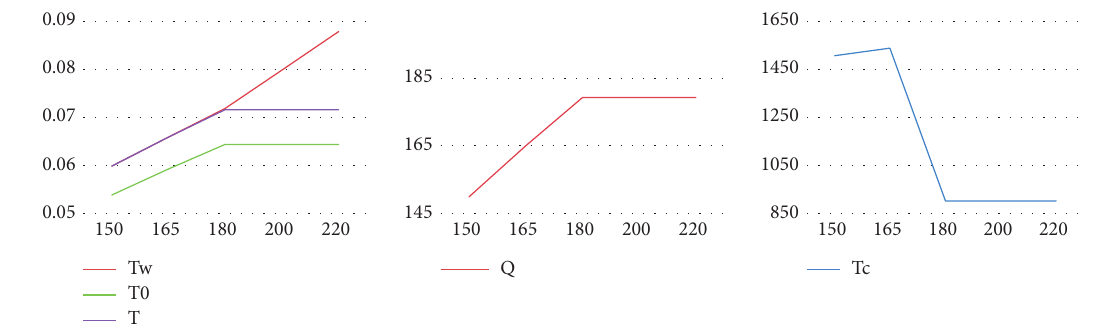
Figure 10: The effect of parameter W on decision variables.